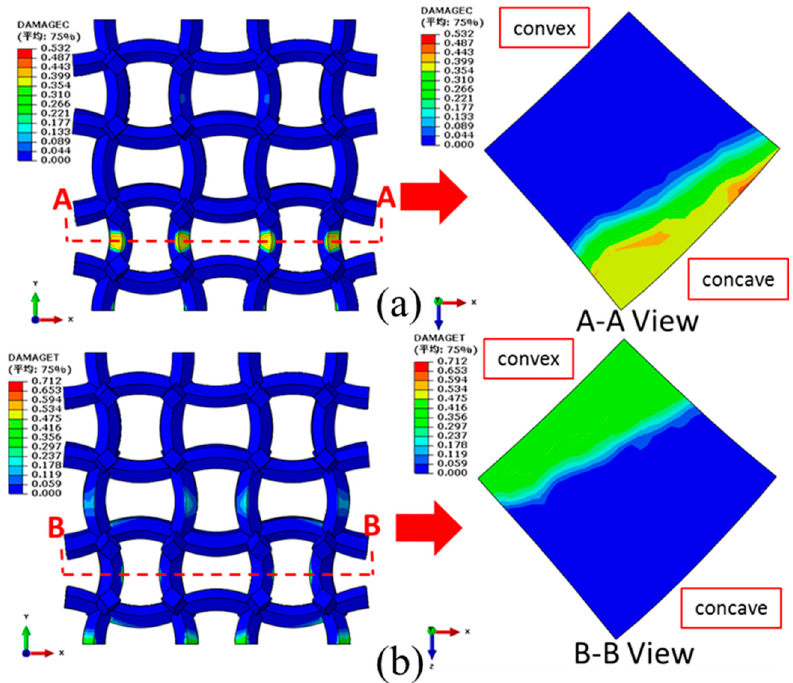
Figure 13. Damage distributions of the CCF1 under the compressive displacement of 1 mm (uniaxial strain of 5%) in the y direction: ( a ) compressive damages; ( b ) tensile damages.